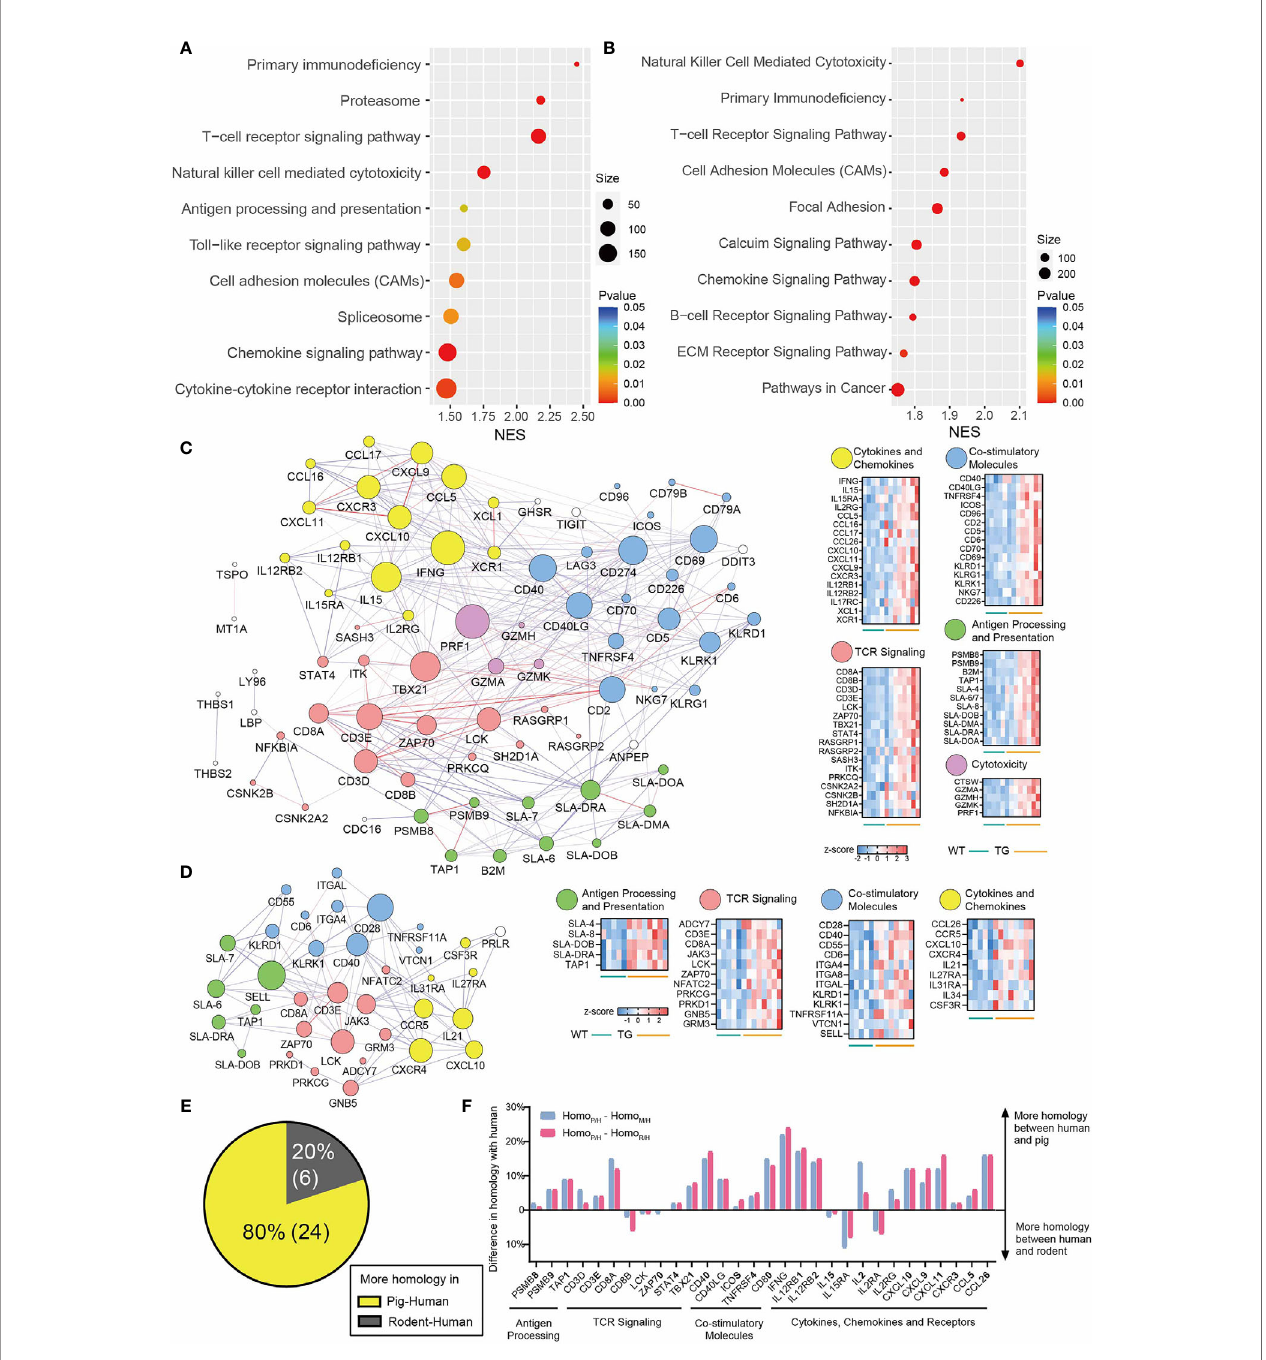
FIGURE 5 | Transcriptome pro fi les of VAT and liver. (A, B) GSEA enrichment of signi fi cant up-regulated KEGG pathways in VAT (A) and liver (B) of TG pigs. (C, D) Protein – protein interaction analyze and heatmap of core enrichment genes in VAT (C) and liver (D) of TG pigs. Genes were clustered by their function in CD8 + T cell activation: antigen processing and presentation (green), TCR signaling (red), co-stimulation and co-inhibition (blue), cytokine and chemokine signals (yellow) and cytotoxicity (violet) heatmap of core enrichment genes in VAT. (E, F) 30 CD8 + T cell-related genes that differentially expressed in TG vs. WT pigs were used for protein sequence alignment. (E) Percentage of genes that have more homology between human and pig (yellow) and genes that showed more homology between human and rodent (gray). (F) The difference in homology with human was calculated by homology between pig and human (Homo P/H ) minus homology between mouse and human (Homo M/H ), shown in pink column; and calculated by homology between pig and human (Homo P/H ) minus homology between rat and human (Homo R/H ), shown in blue